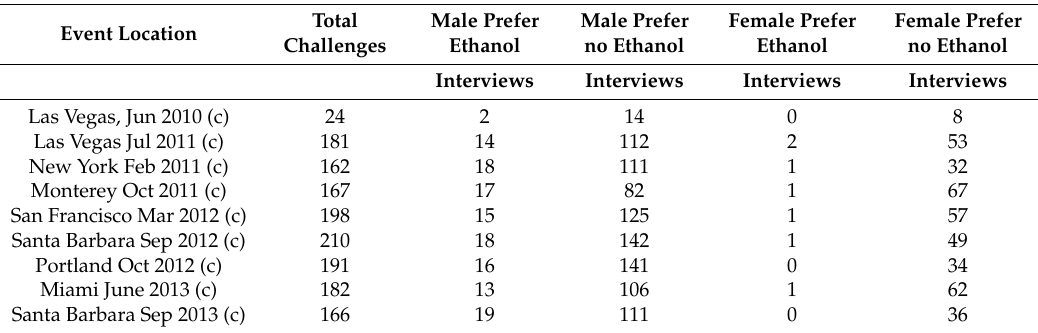
Table 3. Male vs. female preferences for ethanol aroma (% by gender). Participants at spirits events were randomly invited to sniff sample the same spirit in a traditional vessel versus the engineered vessel, in a side-by-side comparison without suggestive comment. Spirits varied by event and control spirit choice did not affect participants’ preference for ethanol. 13% of the tested male population preferred ethanol in the aromas, as did 2% of the females tested. Approximately 30% of females asked to participate declined because they did not want to smell straight spirits. Study details are presented in Section 2